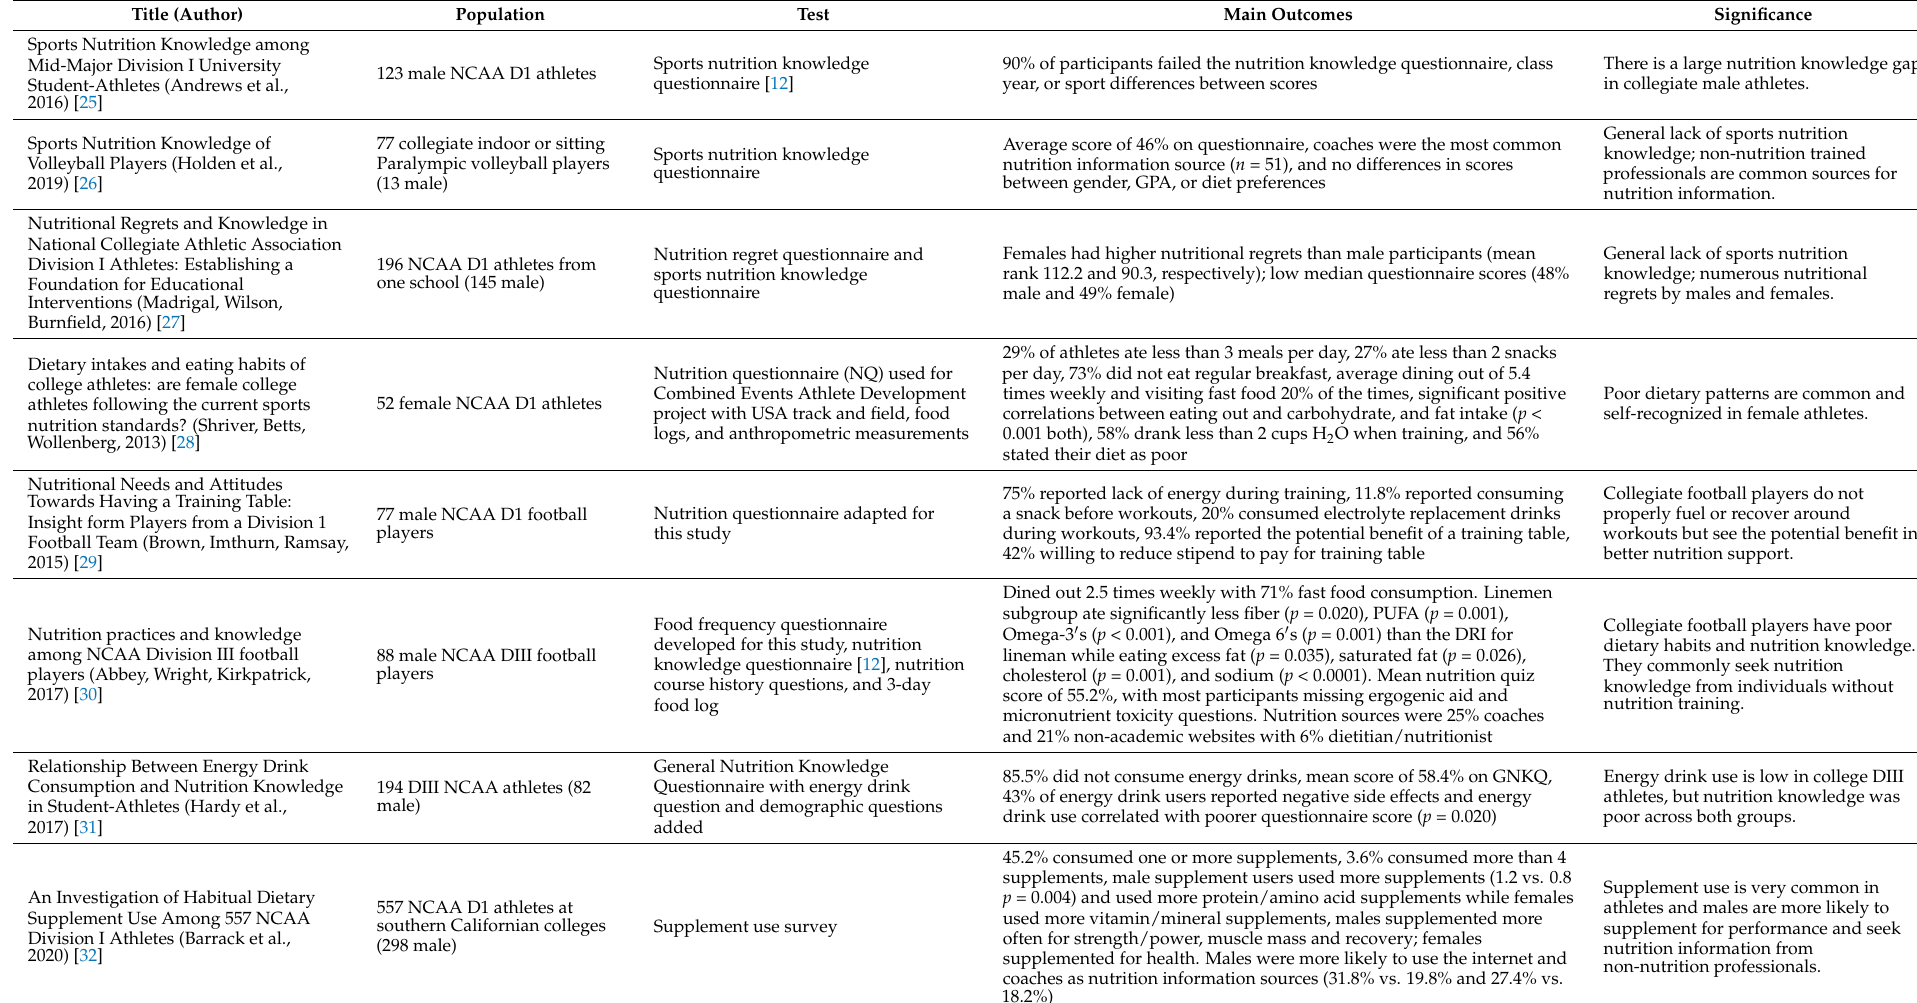
Table 1. Summary table of articles used demonstrating nutrition knowledge of student